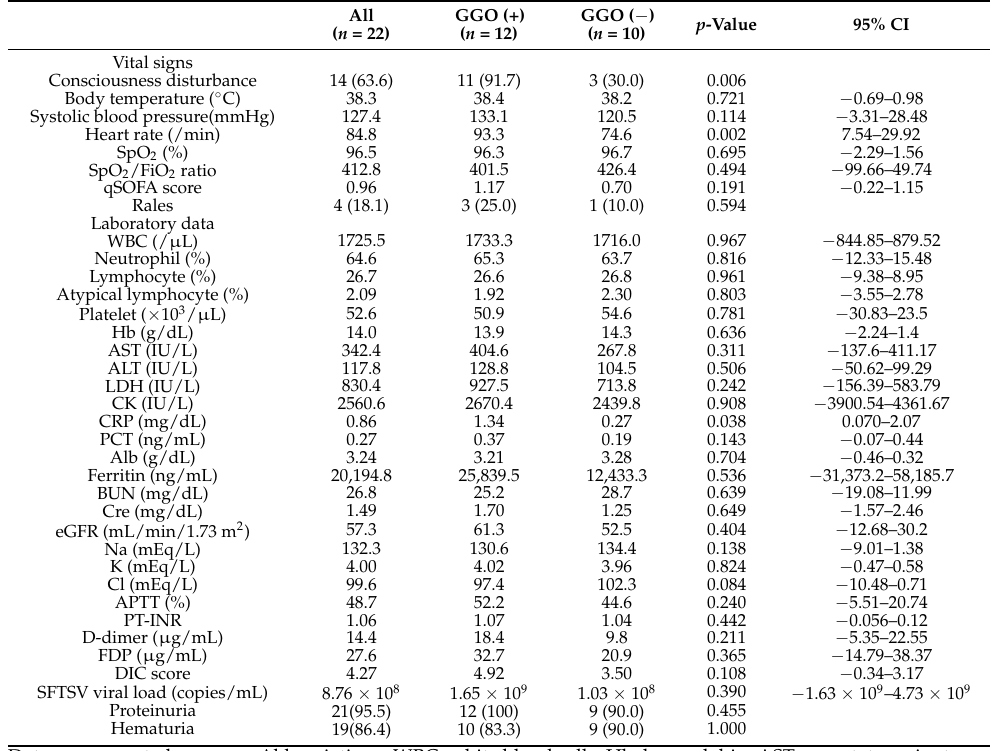
Table 4. Vital signs and laboratory data on the admission of patients with SFTS.